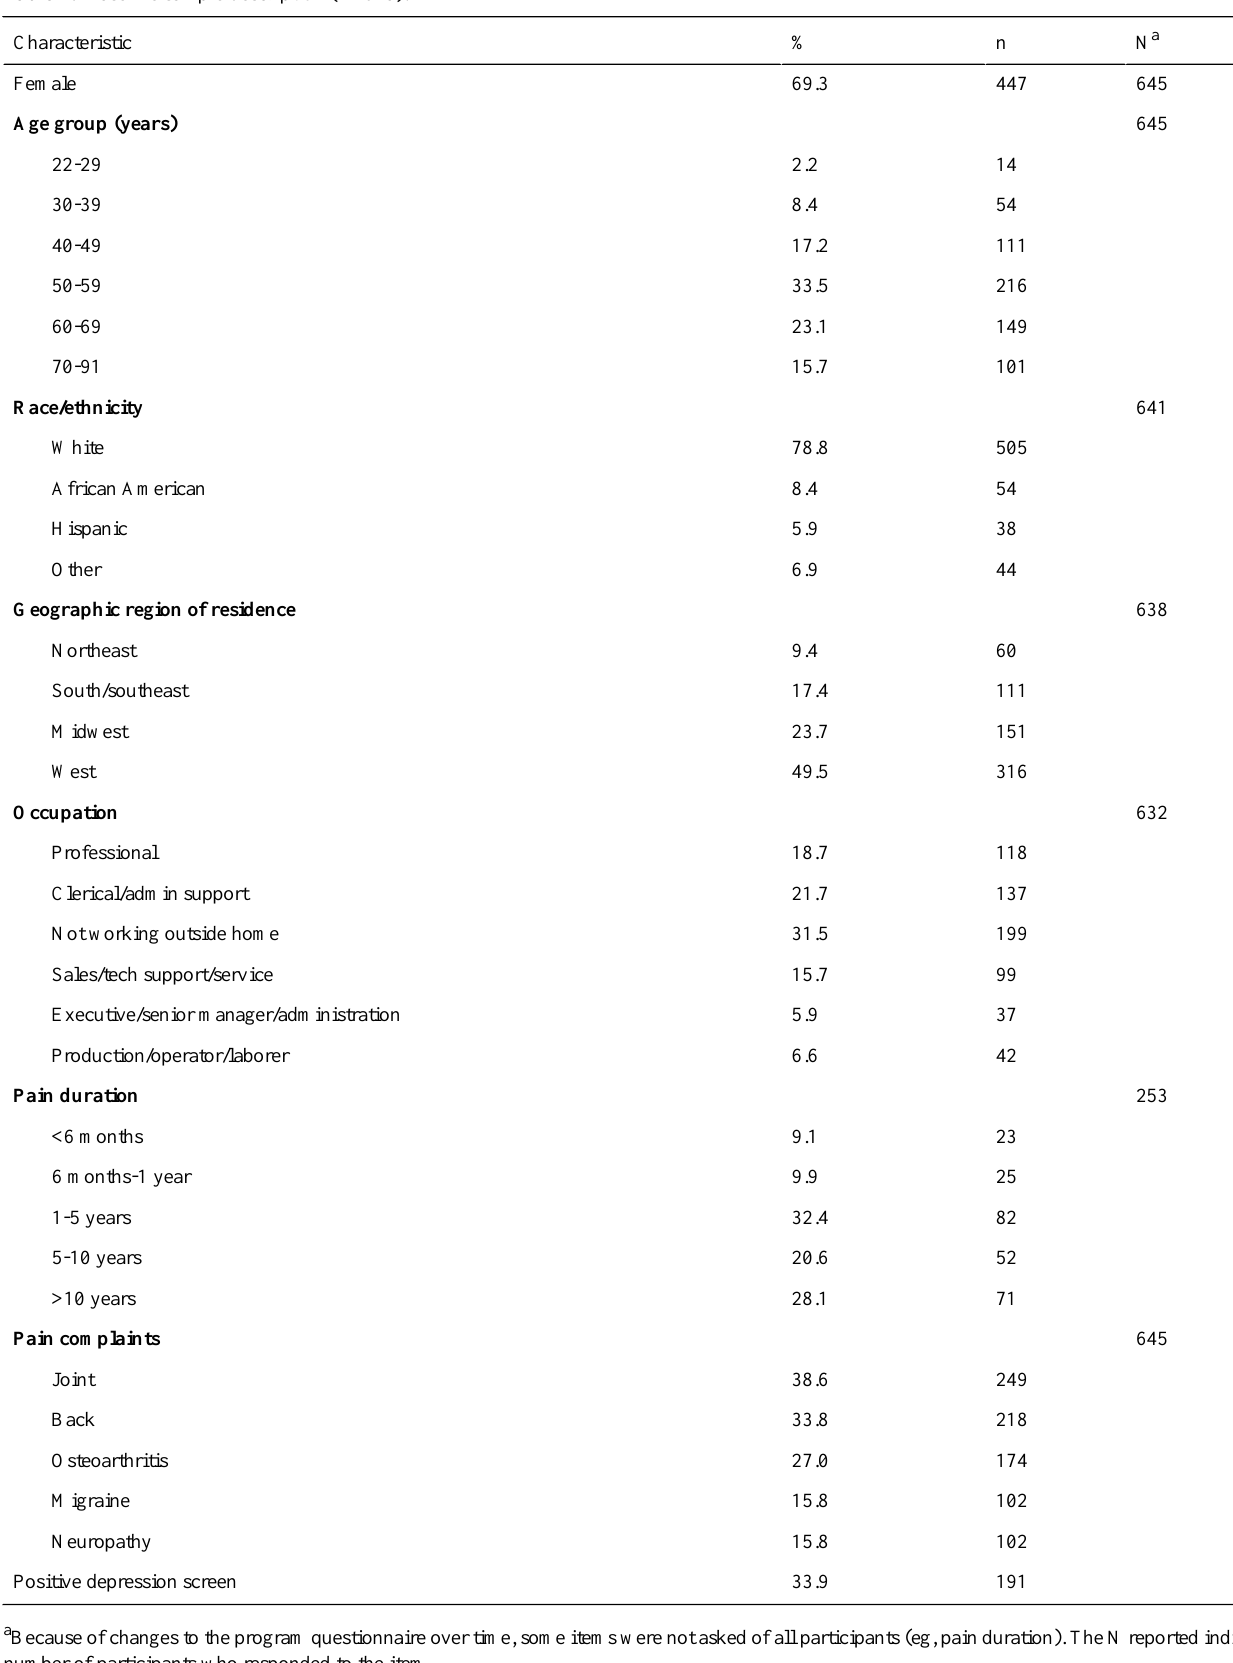
Table 1. Baseline sample description